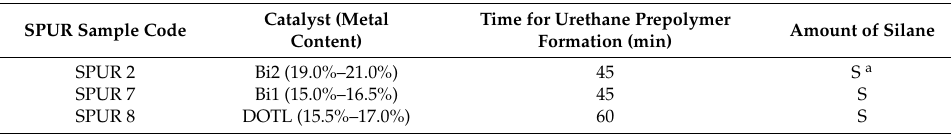
Table 5. The evaluation of different catalyst activities.